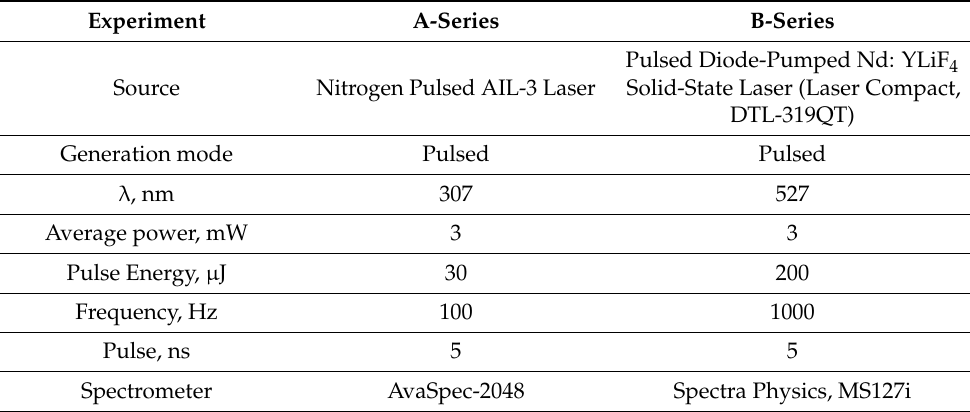
Table 1. Schemes of experiments, laser sources, and spectrometers.